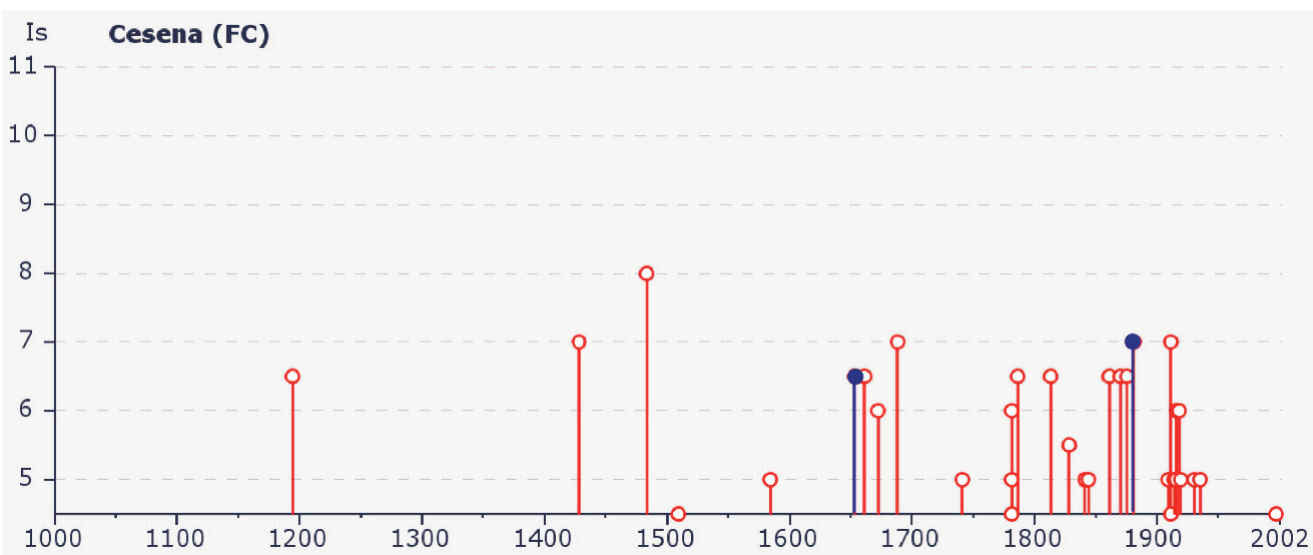
Figure 7. Seismic history of the city of Cesena, from the Italian macroseismic database (Database Macrosismico Italiano, DBM04; available online at